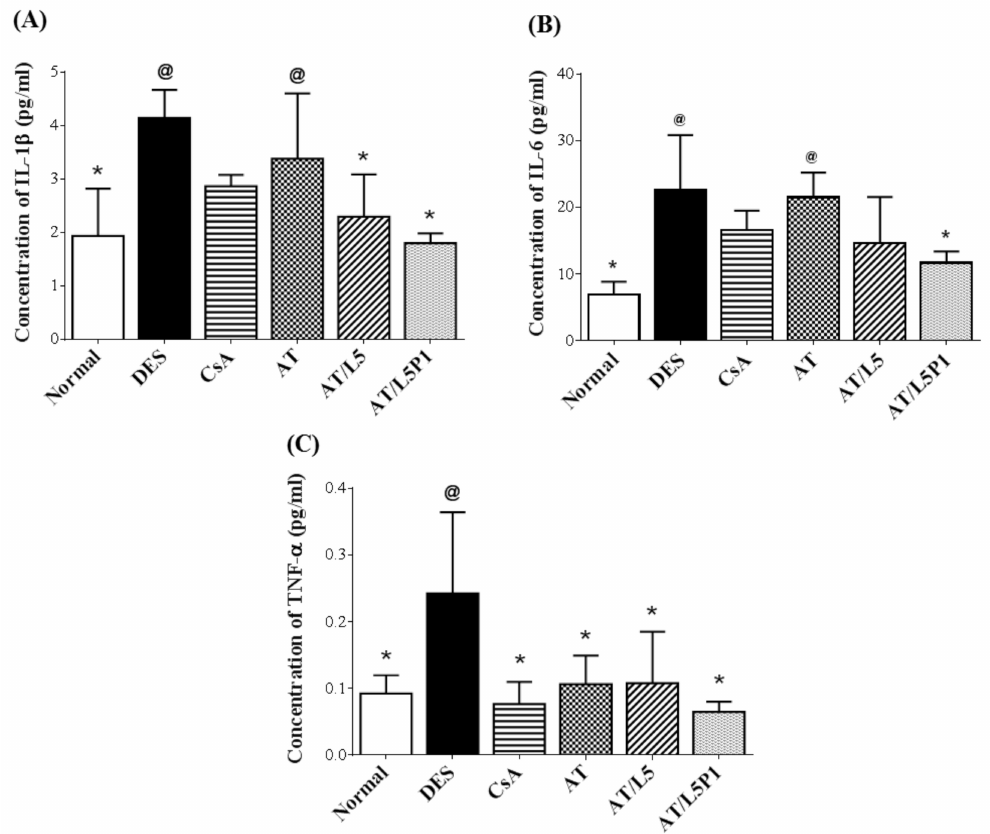
Figure 9. Quantification of inflammatory cytokines extracted from mouse corneas. Cytokine concentration of ( A ) IL-1 β , ( B ) IL-6, and ( C ) TNF- α . Data were analyzed using the one-way ANOVA and are expressed as the mean ± standard deviation (SD); n = 6, (@ p < 0.05 compared with the control group, * p < 0.05 compared with the DES